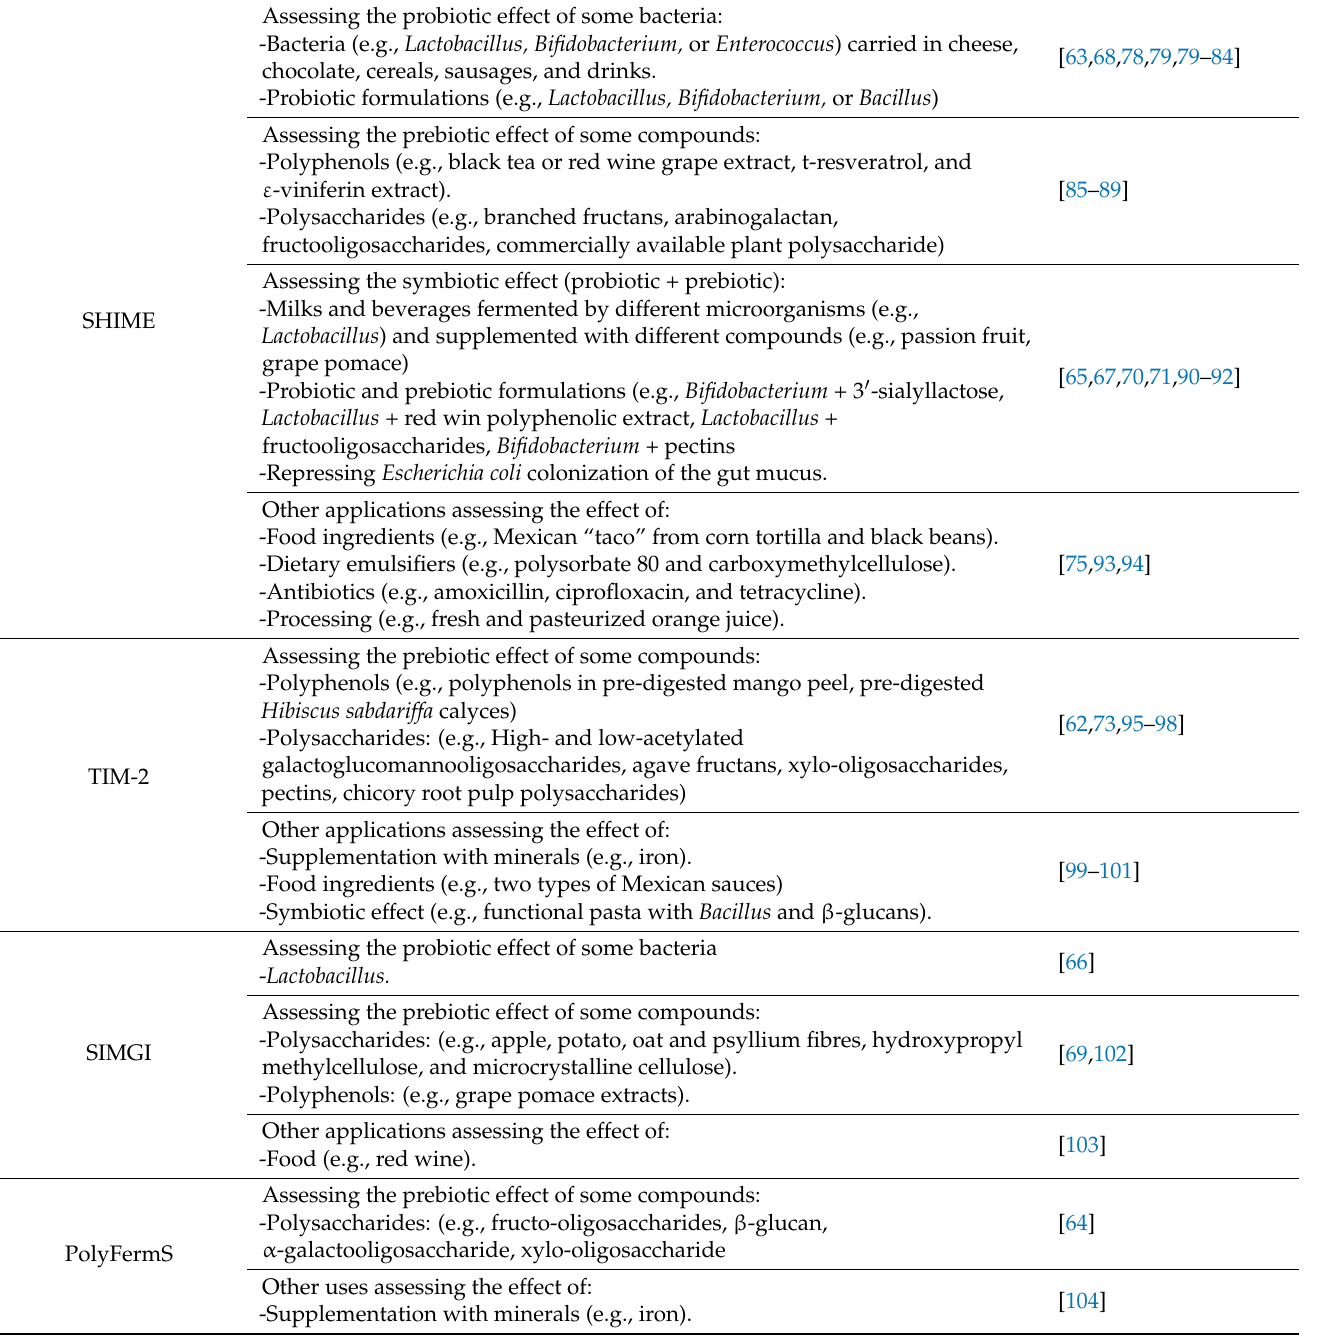
Table 2. Applicability of dynamic in vitro colonic models in the food science and technology field from 2011 to 2021. Dynamic Model Main Objective and